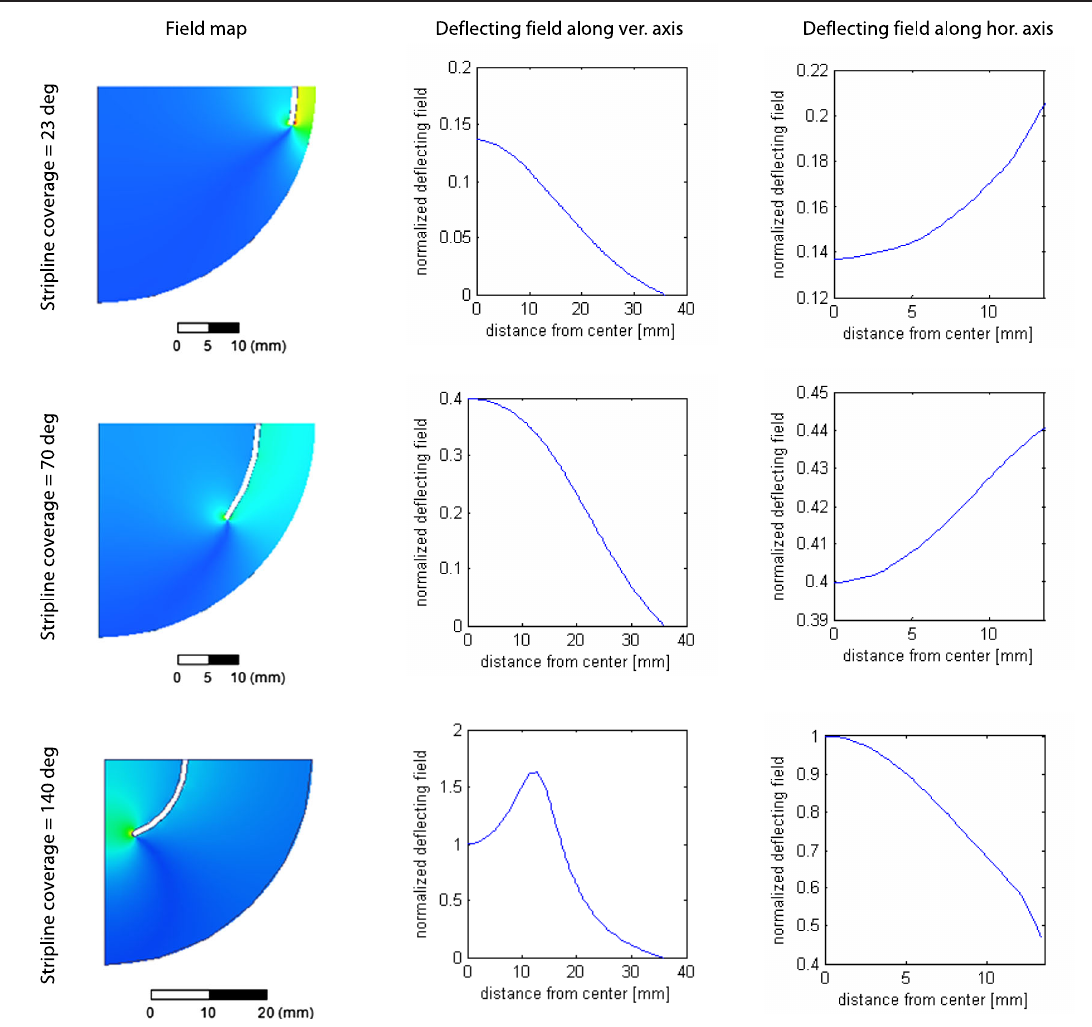
FIG. 7. Deflecting field map and profile of strip-line pulse kicker for various coverage angle. The deflecting field profiles are normalized to the on-axis field of 140 degree coverage angle.